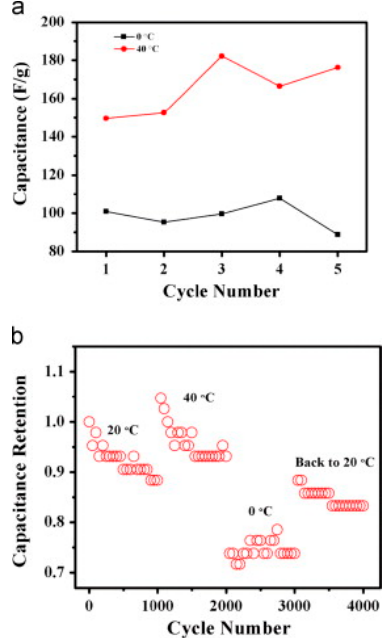
Figure 11. Temperature-dependent performances for composite electrode of Fe 3 O 4 /carbon using 1 M KOH electrolyte. ( a ) Specific capacitance variations at 1 A g − 1 under repeated cycles of heating and cooling. ( b ) Cyclic stability at 2 A g − 1 under various temperatures [148].